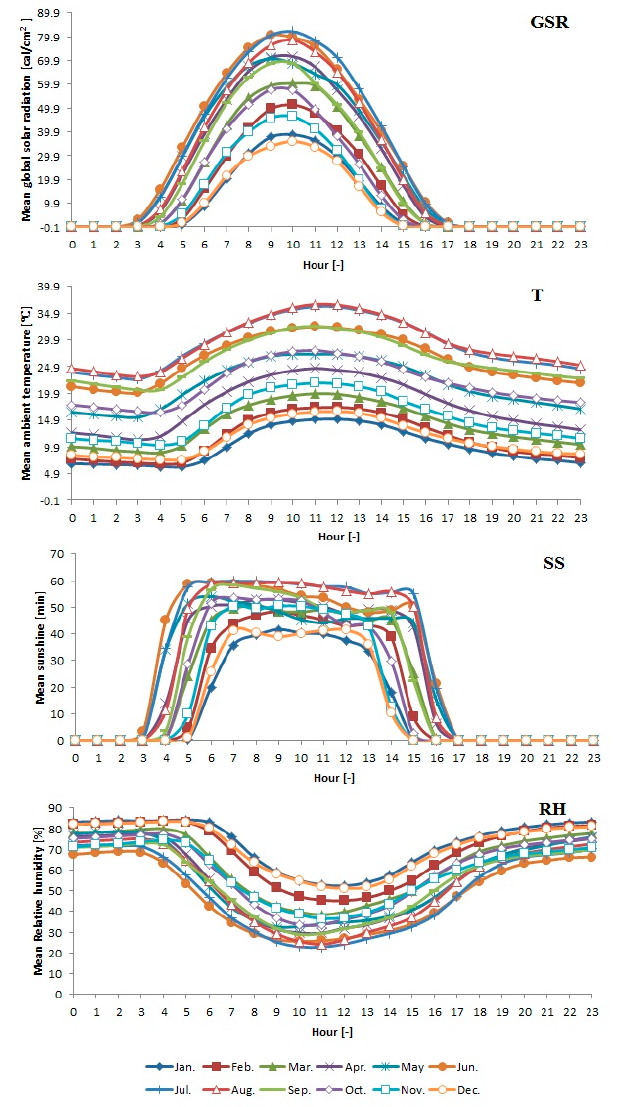
Figure 9. Mean hourly meteorological parameters for an average day for the period